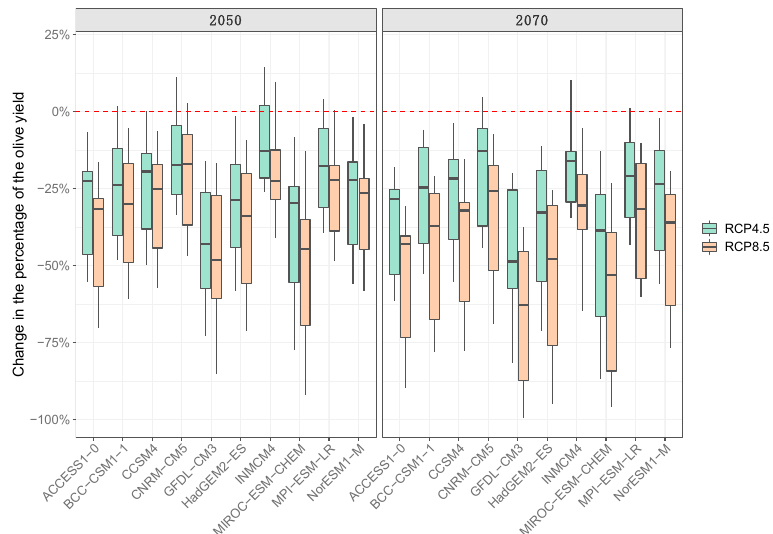
Figure 3. Changes in the percentage of olive production according to 10 future General Circulation Models (GCMs) under two scenarios of emission (Representative Concentration Pathways, 4.5 and 8.5 W/m 2 ) for two time periods (2050 and 2070).